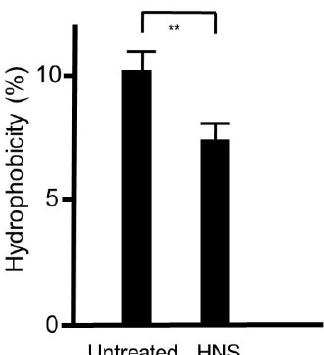
Figure 6. Inhibitory effects of the HNS on the biofilm hydrophobicity of S. mutans . S. mutans cells were treated with HNS (500 μg/mL) at the exponential phase, and the cell surface hydrophobicity (A600 of 1.0) was determined. The value of the control strain was set at 100%. Data show the mean ± SD ( n = 6). **: p < 0.01 by Student’s t ‐test.